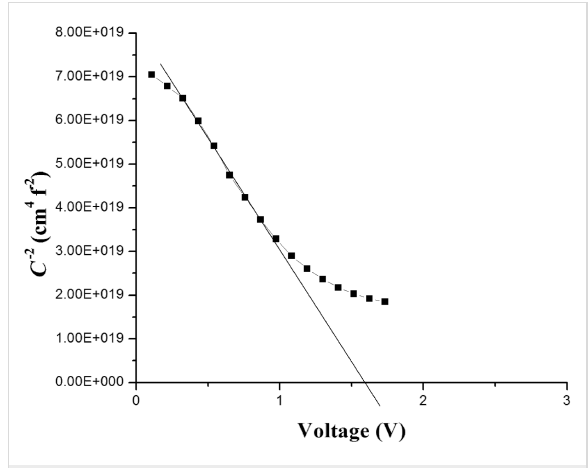
Figure 3: 1/ C 2 versus voltage curve of the nano heterojunction diode.